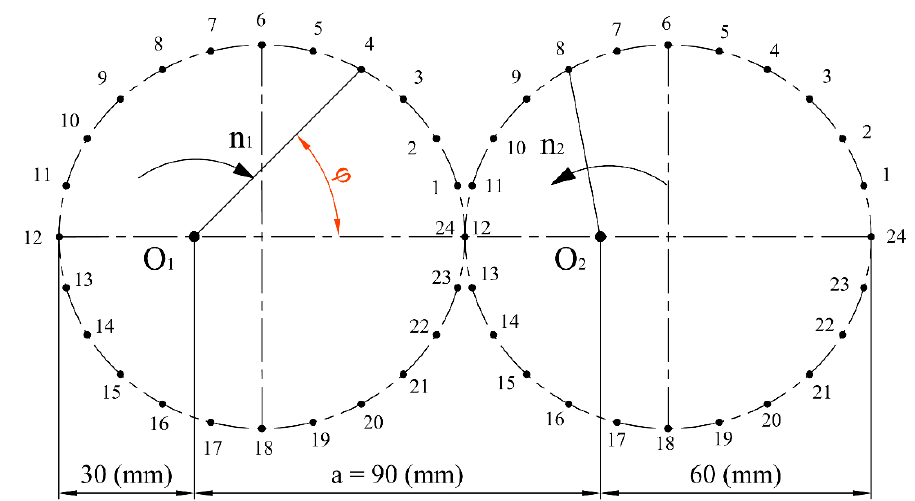
Figure 20. Defining the angle of rotation of the driving gear.